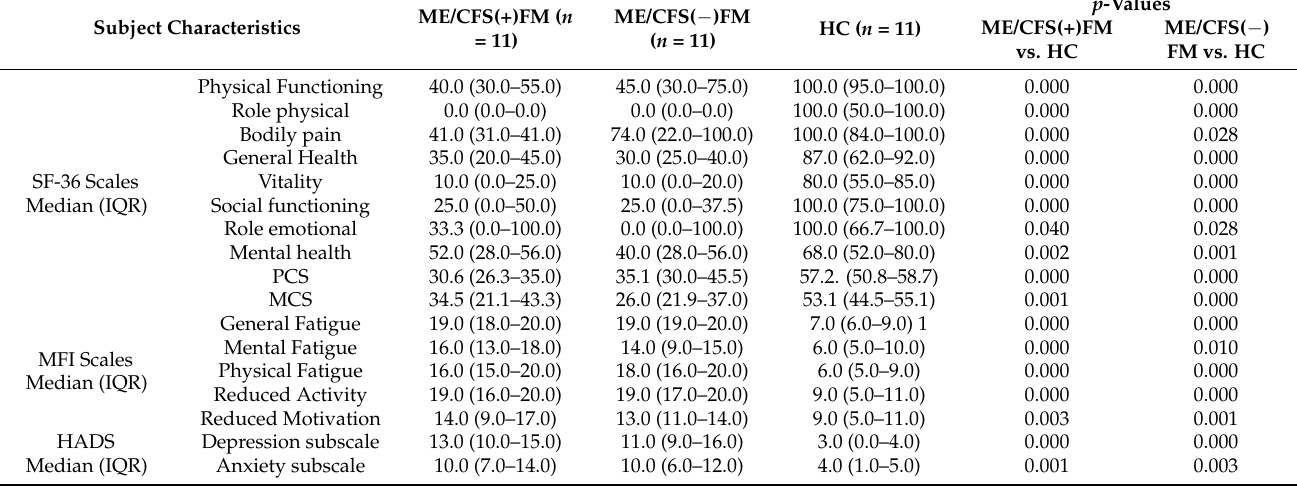
Table 3. Fatigue, depression, anxiety, and baseline health status assessment in patients and healthy controls. FM—fibromyalgia, HADS—Hospital Anxiety and Depression Scale, HC—heathy controls, IQR—interquartile range, PCS—physical component score; MCS—mental component score, ME/CFS—myalgic encephalomyelitis/chronic fatigue syndrome, MFI—multidimensional Fatigue